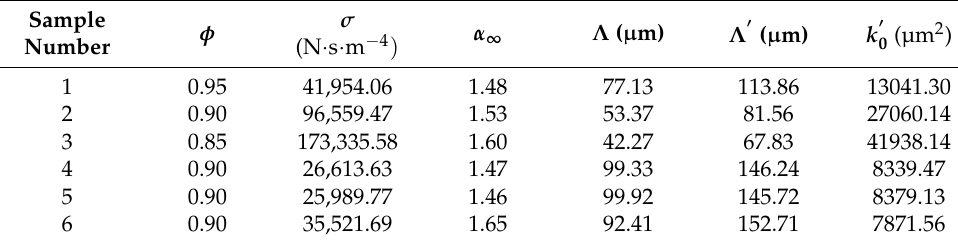
Table 4. Results of the non-acoustical parameters in the JCAL model for six felt samples.